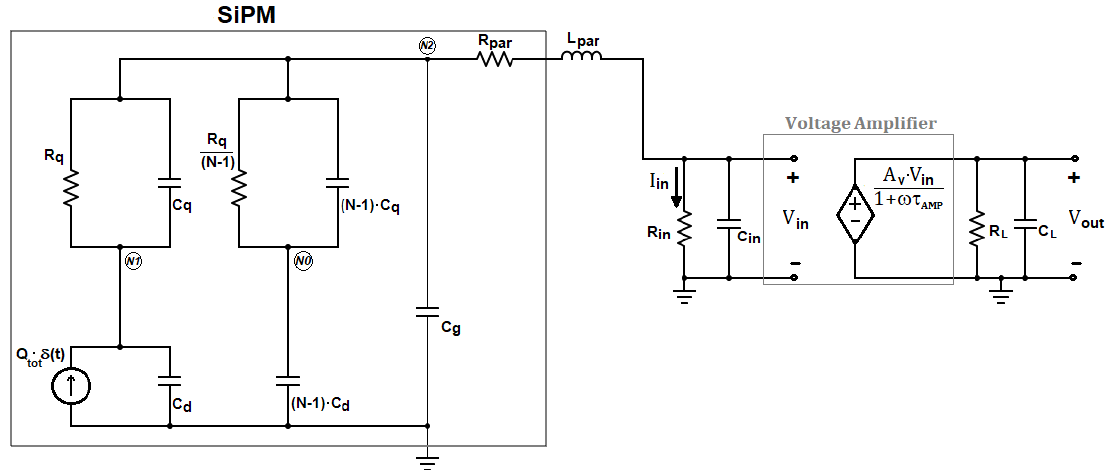
Figure 3. Model of the SiPM coupled to a voltage-mode front-end circuit.